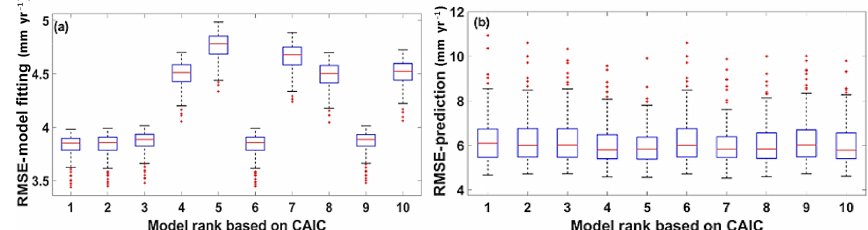
Figure 6. RMSE of sub-sample (a) model fitting and (b) model prediction of top 10 models according to CAIC.